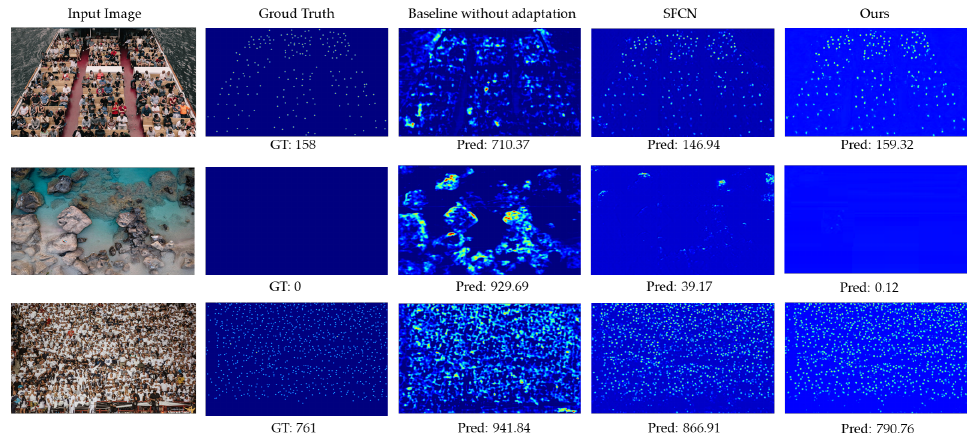
Figure 7. The comparison results between ground truth, baseline with no adaptation, SFCN [10], and our method.